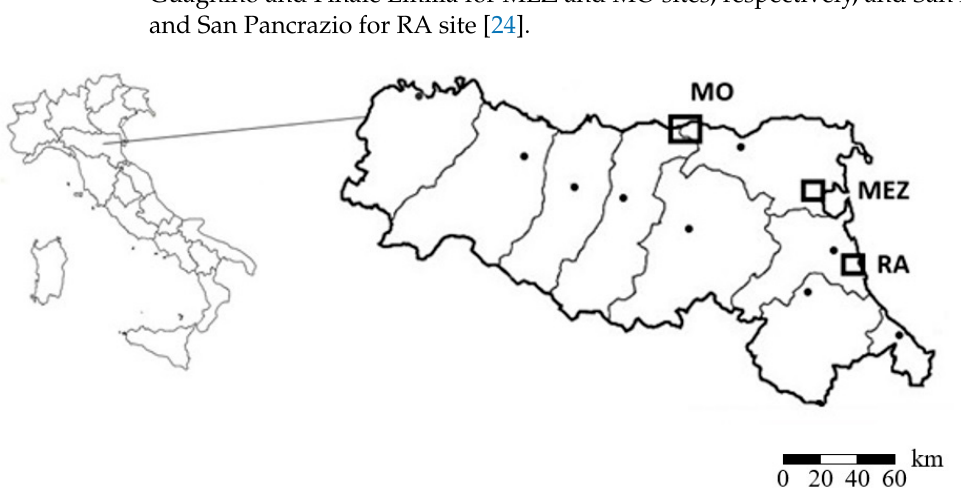
Figure 1. Map of Italy with magnification of the Emilia Romagna region and indication of the study sites.